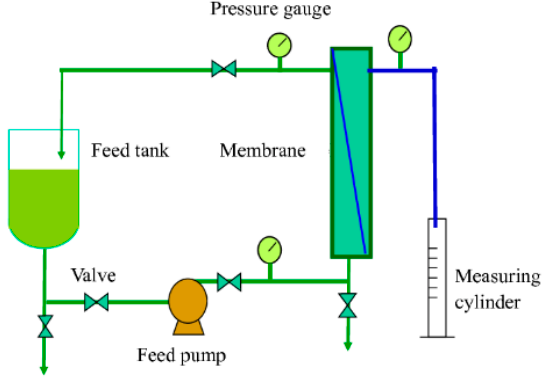
Figure 1. Schematic representation of the cross-flow ultrafiltration experiment set-up.